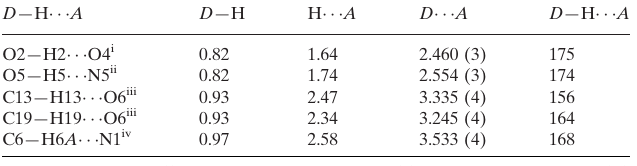
Hydrogen-bond geometry (A˚ , (cid:3)